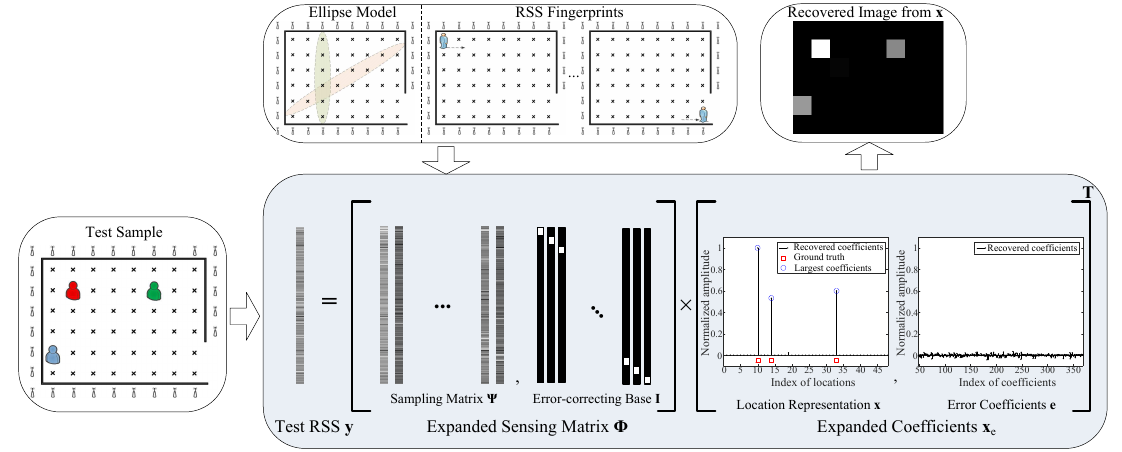
Figure 1. Schematic diagram of enhanced sparse representation-based device-free localization